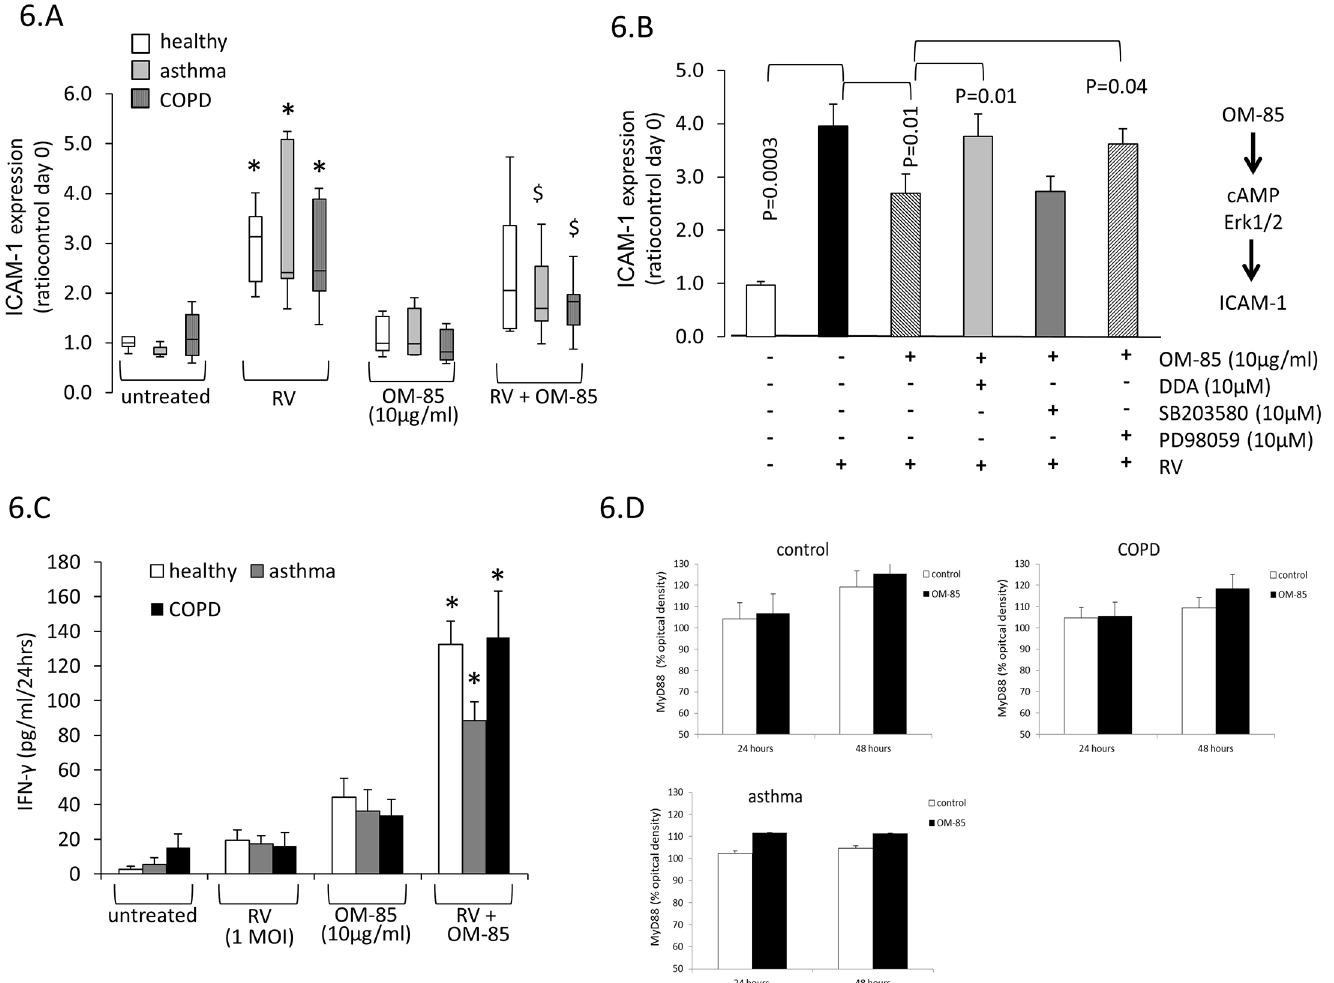
Fig 6. RV induced expressionof ICAM-1 on BEC is prevented by OM-85 through cAMP and Erk1/2 MAPK. (A) Increased expressionof ICAM-1 by RV and its inhibitionby OM-85 pre-incubation (24 hrs). Box-plots represent medianand 95% confidenceinterval of BEC derived from: non-asthma, non- COPD controls (n = 6), asthma (n = 10), and COPD (n = 7). (B) Show the effect of cell signal inhibitors(DDA for cAMP; SB203580for p38 MAPK and PD98059for Erk1/2 MAPK) on ICAM-1 expressioninducedby RV in the presenceand absenceof OM-85 (10 μ g/ml). (C) RV and OM-85 inducedthe secretionof IFN- γ by primary humanBEC (n = 5 in each group). (D) OM-85 has a non-significant increasingeffect on MyD88 expressionby BEC (n = 5 in each